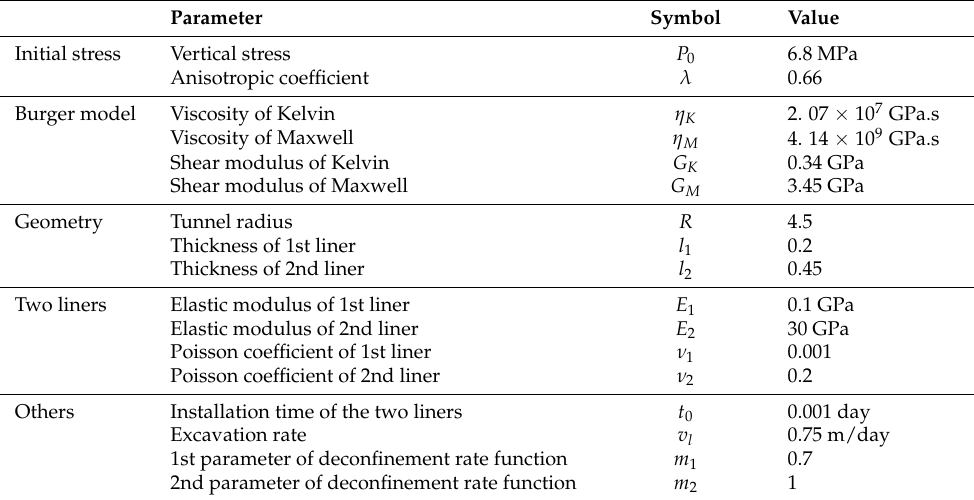
Table 1. Input parameters for the analytical